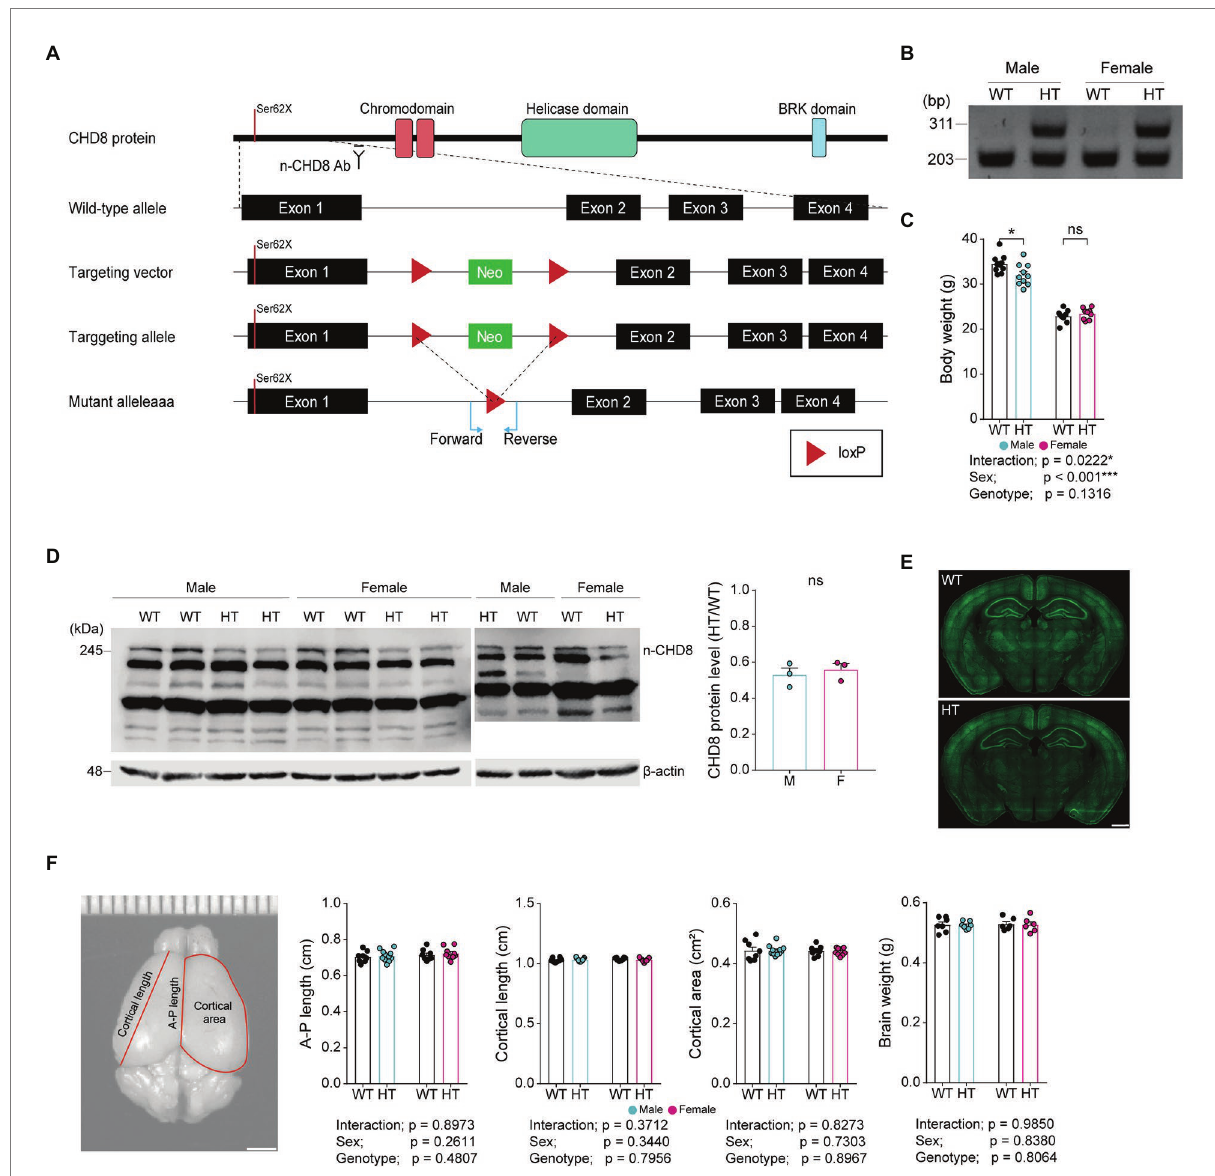
FIGURE 1 CHD8-S62X knock-in strategy, PCR genotyping, body weight, CHD8 protein levels, gross brain morphology, and brain size in Chd8 +/S62X male and female mice. (A) Chd8 knock-in (S62X) strategy. (B) PCR genotyping of WT and Chd8 +/S62X mice. WT, wild-type; HT, heterozygote ( Chd8 +/S62X ). (C) Chd8 +/S62X male and female mice (4 months) show largely normal postnatal body weights compared with WT mice. (n = 10 mice [male-WT], 10 [male-HT/heterozygote], 8 [female-WT], and 9 [female-HT], * p < 0.05, ns, not significant, two-way ANOVA with Holm-Sidak test). (D) Chd8 +/S62X male and female mice (P15) show the expected ~50% decrease in total brain levels of the CHD8 protein compared with WT mice, as shown by immunoblotting of whole-brain lysates. ( n = 3 mice [male-WT], 3 [male-HT], 3 [female-WT], and 3 [female-HT], ns, not significant, Student’s t -test). Other bands indicate non-specific protein bands that cross-react with the antibody. (E) Chd8 +/S62X male and female mice (4 months) show largely normal gross brain morphology, as shown by NeuN (neuronal marker) staining. (F) Chd8 +/S62X male and female mice (4 months) show largely normal brain sizes compared with WT mice, as shown by anterior–posterior (A–P) length, cortical length, and cortical area of the brain. ( n = 8 mice [male-WT], 11 [male-HT], 8 [female-WT], and 9 [female-HT], two-way